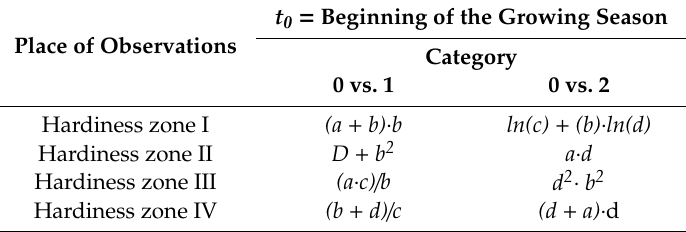
Table 4. The most suitable features for separating between the reference data (category 0) and category 1 and 2 datasets. The original variables are denoted as a , b , c , and d —namely R , T av , T max , and T min